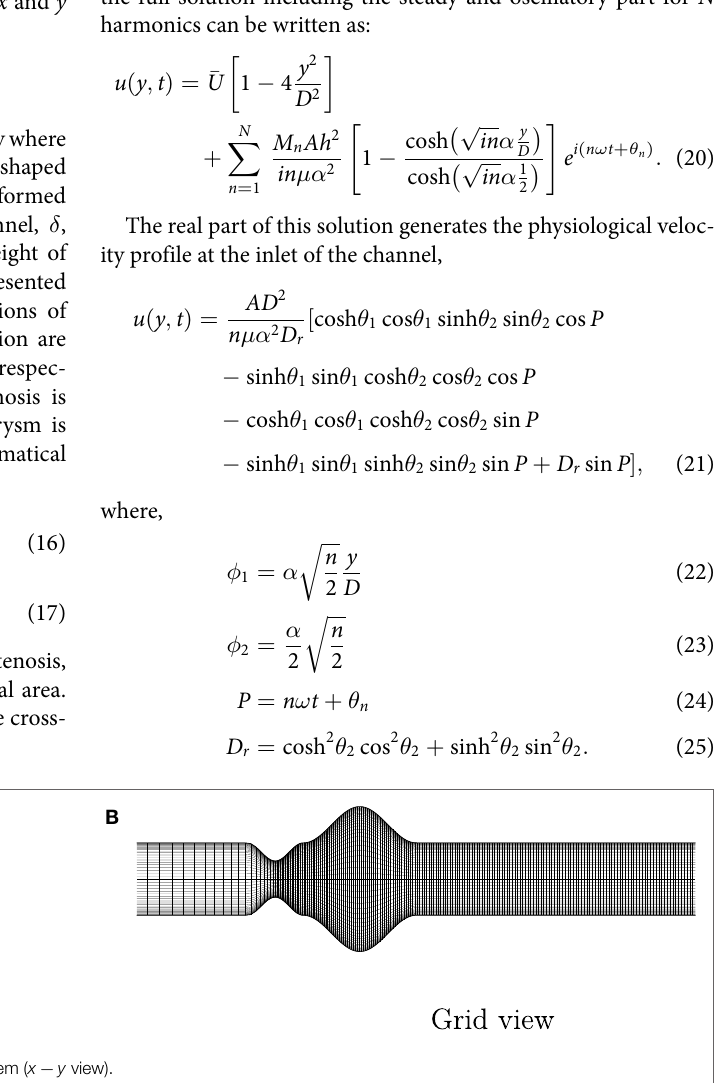
FIGURE 1 | (A) The schematic geometry and (B) A portion of grid system ( x (cid:0) y view).